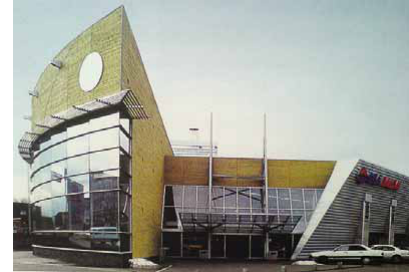
Fig. 16. Exterior view of Kampi chapel in Helsinki